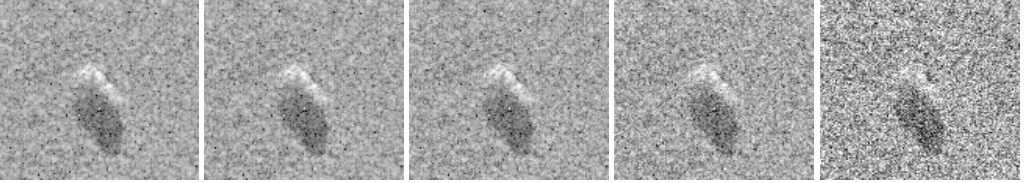
Figure 9. Example of original slice ( left ) and modified images with noise. Proportions are 2%, 4%, 8% and 16%, respectively, from left to right.